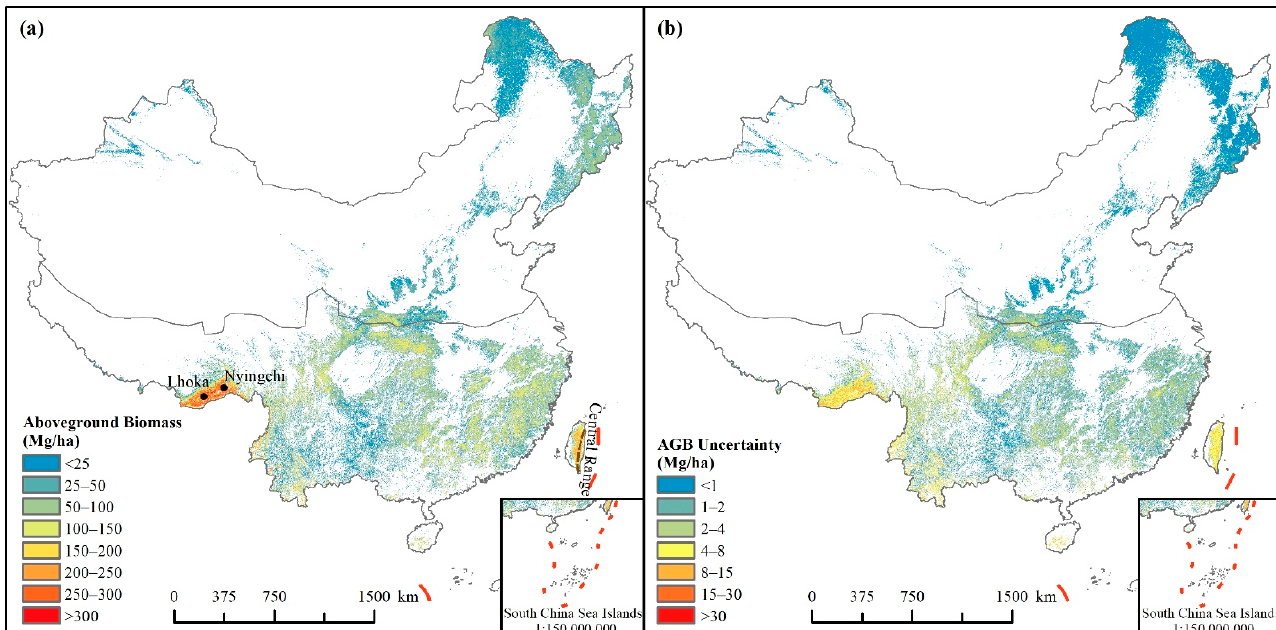
Figure 5. Spatial distribution of forest AGB and uncertainty in China. ( a ) Forest AGB and ( b ) Uncertainty.